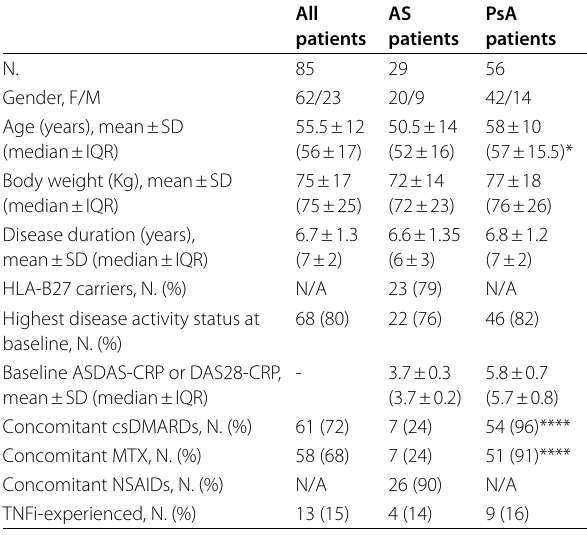
Table 1 Baseline characteristics of the patients